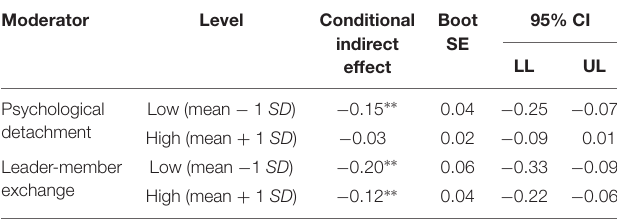
TABLE 5 | Conditional indirect effects at high and low levels of psychological detachment and leader–member exchange for customer